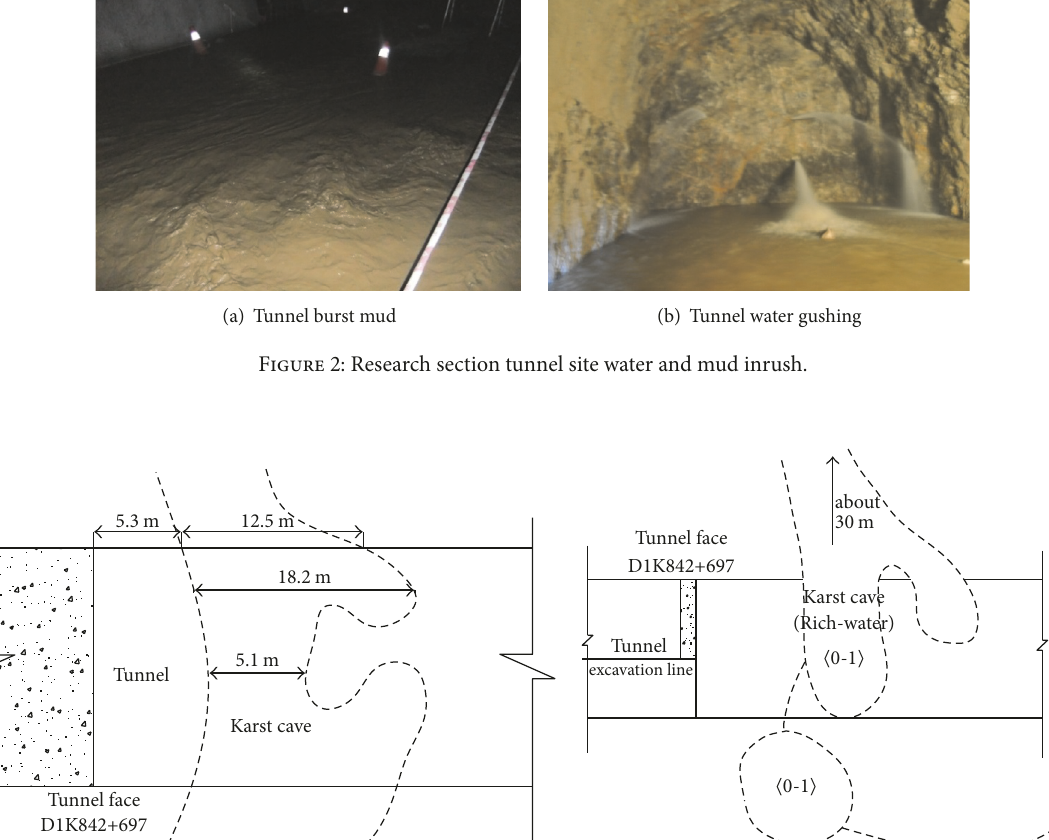
free. A water permeable boundary is set around the seepage boundary and its bottom, which allows the surrounding karst water and fractured water to carry the water supply to